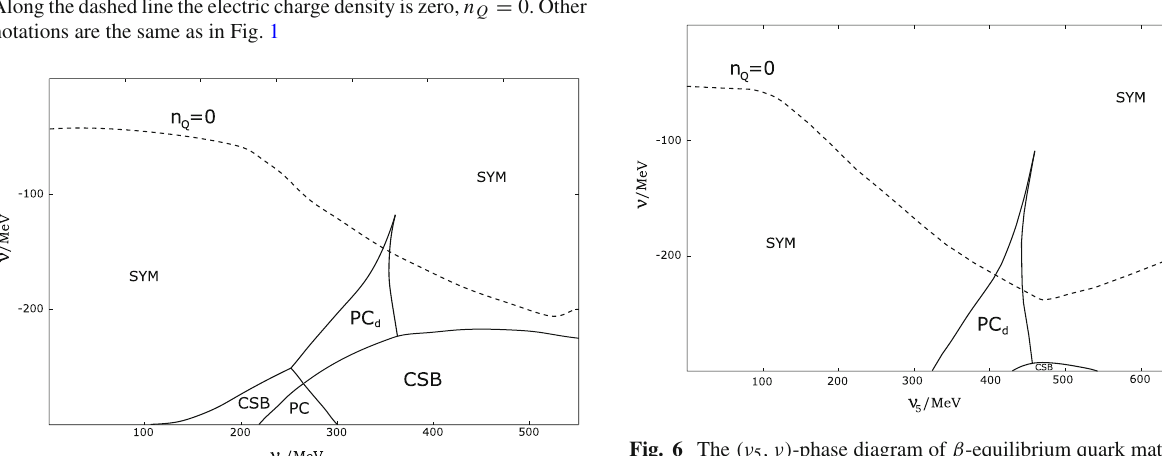
Fig. 5 The (ν 5 ,ν) -phase diagram of β -equilibrium quark matter (see the model (7), (8)) at μ = 450 MeV and μ 5 = 0 in the chiral limit, m 0 = 0. All the notations are the same as in Figs. 1, 2 and 3